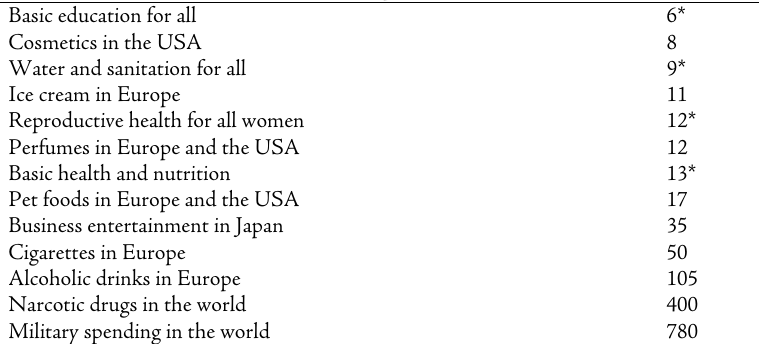
Table 1. The World's Priorities? (annual expenditure,